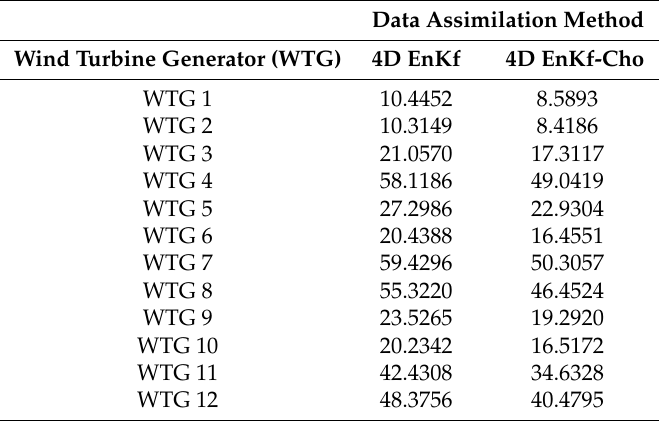
Table 4. L − 2 error norms of wind energy potential estimations at the initial analysis member. Two ensemble sizes are tried during the